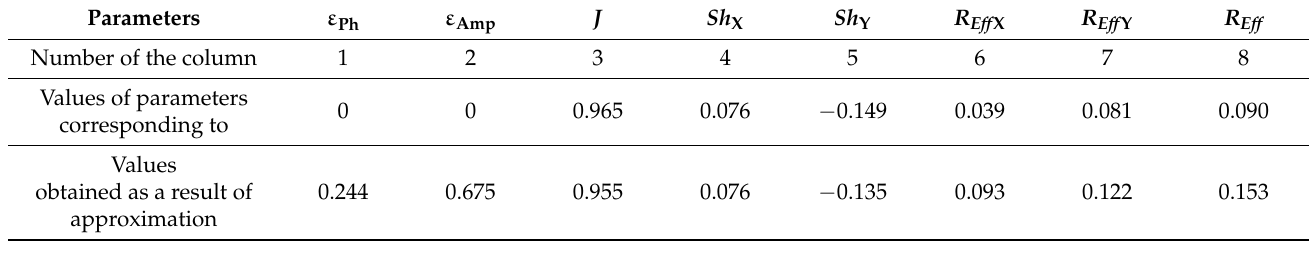
Figure 14. Precision of phase screen approximation. Phase distribution specified by the screen simulating atmospheric turbulence ( a ), amplitude distribution of a beam with initial phase profile specified by this screen ( b ), surface obtained as a result of approximation ( c ), amplitude of a beam ( d ) with initial phase presented in Figure ( c ). Dimensions of computation grid are 1024 × 1024, r 0 = 0.2. Table 6. Characteristics of the beam in the plane of observations. Parameters of numeric experi- ment were the same as in the previous example (Figure 14).